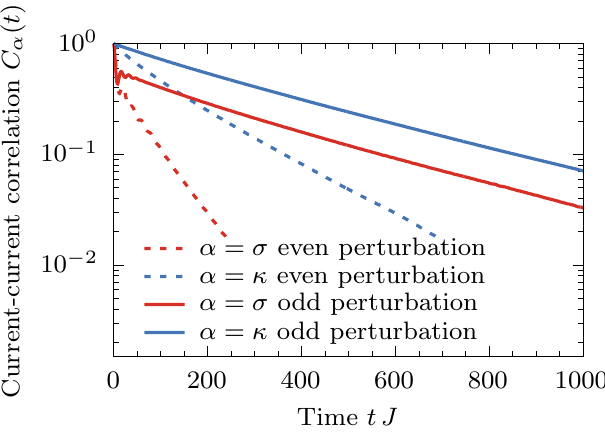
Figure 5: Current correlation function C α ( t ) for the perturbation, Eq. (10), breaking the parity symmetry P (odd perturbations), as compared with P -preserving pertur- bation Eq. (1) (even perturbations). Calculated for L = 28, ∆ = 0.5, g = 0.15, and = S z tot